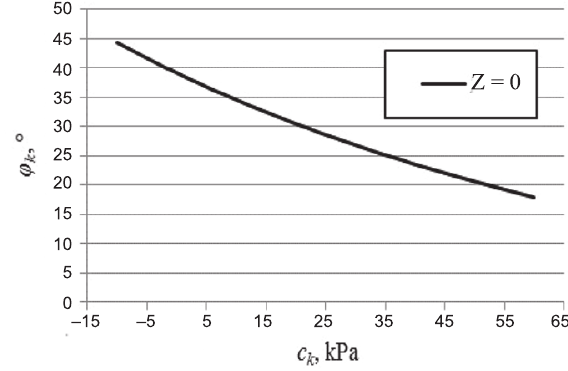
Fig. 1. Reserve of design bearing capacity according to different characteristic shearing parameters of strength